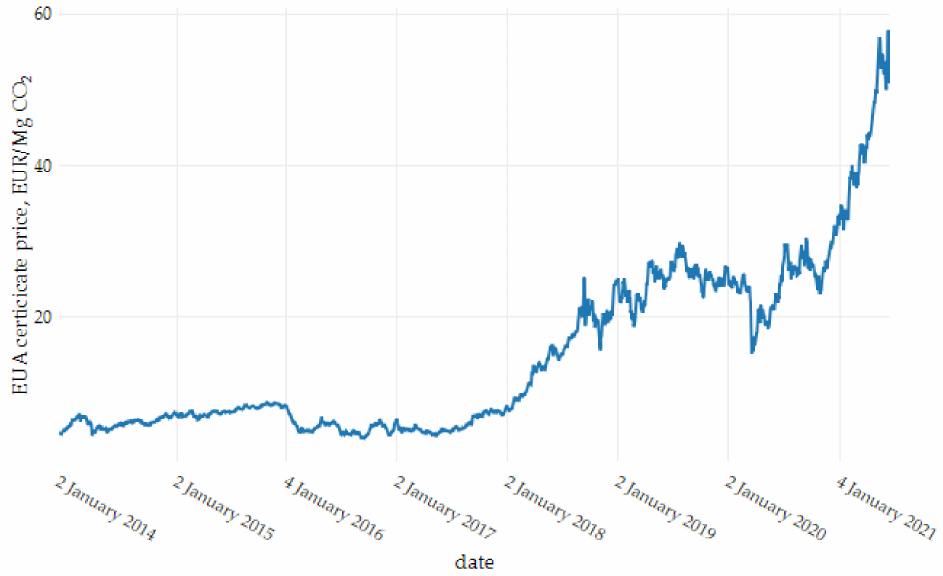
Figure 1. EUA certificate prices in 2014–2021